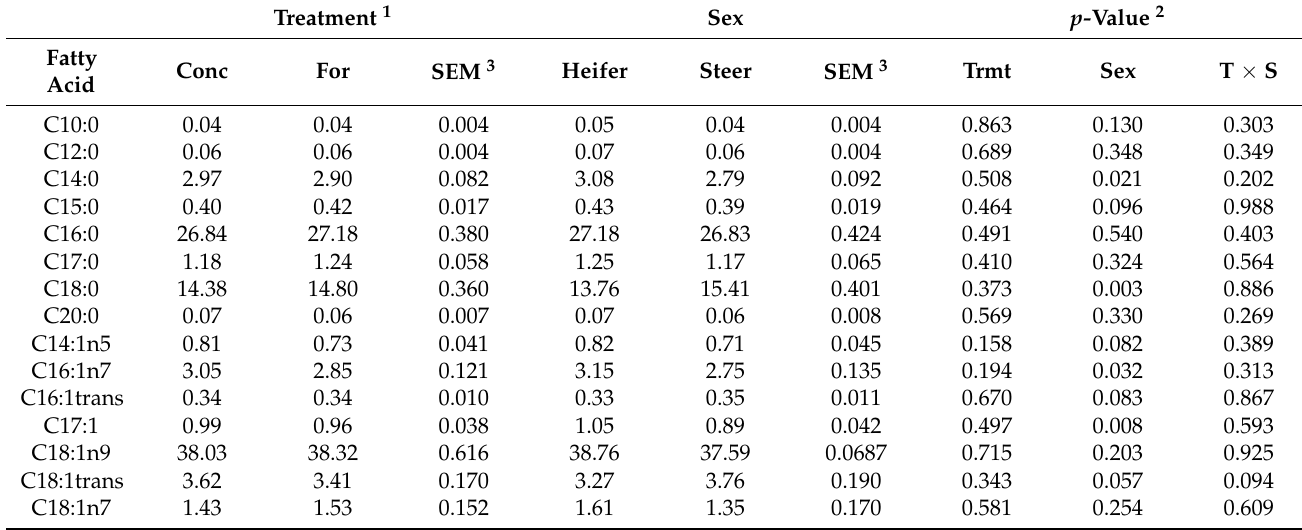
Table 8. Least squares means for the fatty acid composition (%, g/100 g total fatty acids) of progeny from dams fed a prepartum dietary carbohydrate source consisting of concentrate-based (Conc) or forage-based (For) diet during mid- and